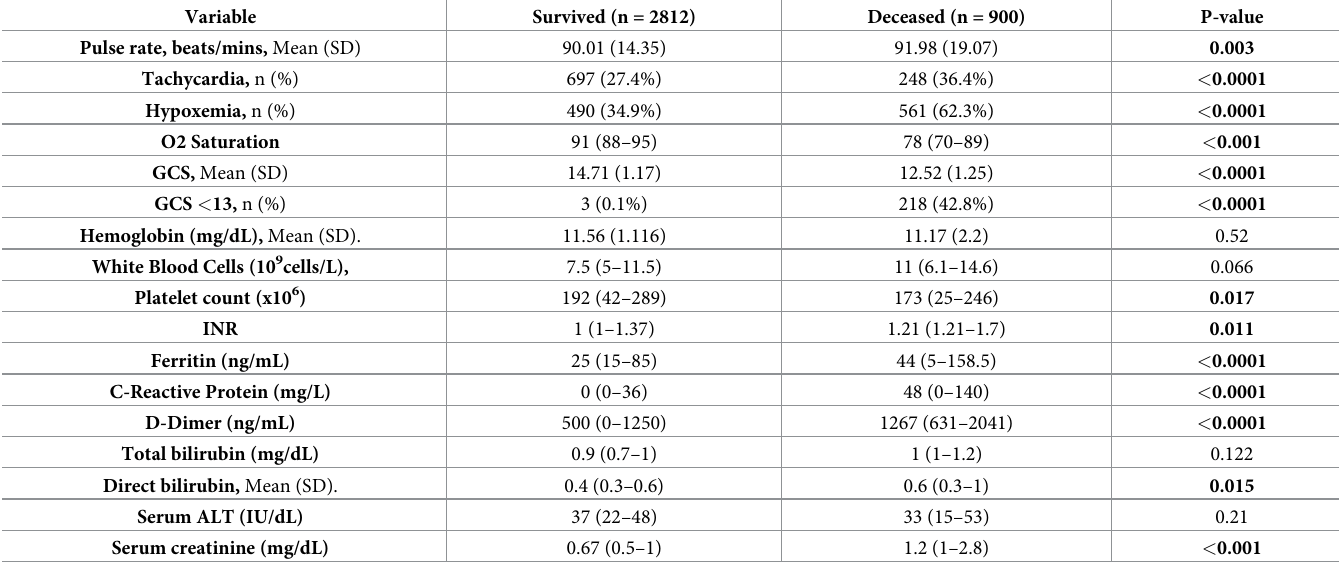
Table 2. Baseline vital signs and laboratory parameters (n =